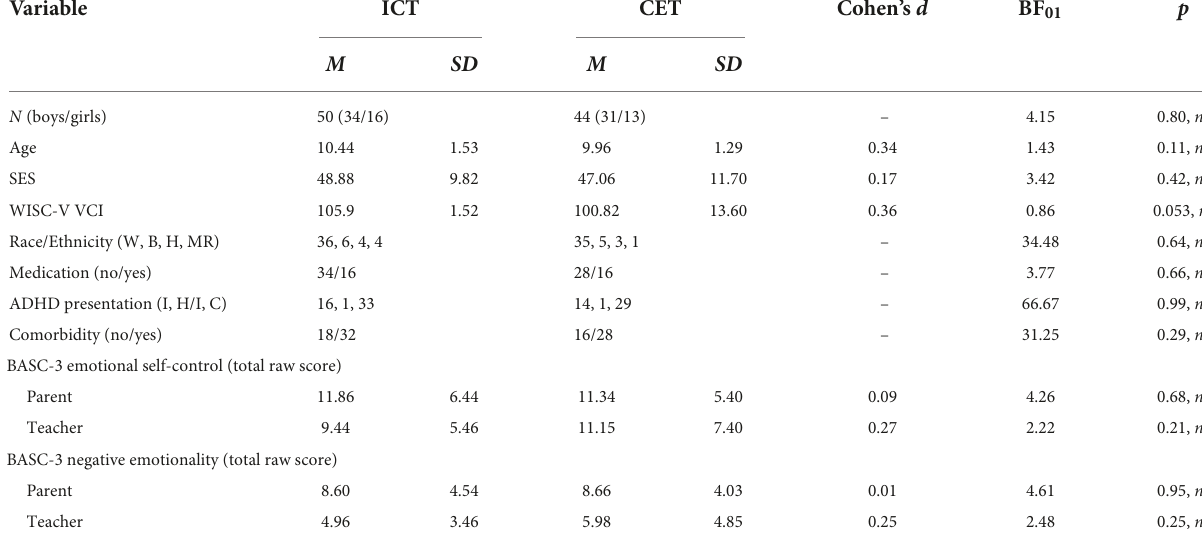
TABLE 1 Sample demographic and pre-treatment characteristics.